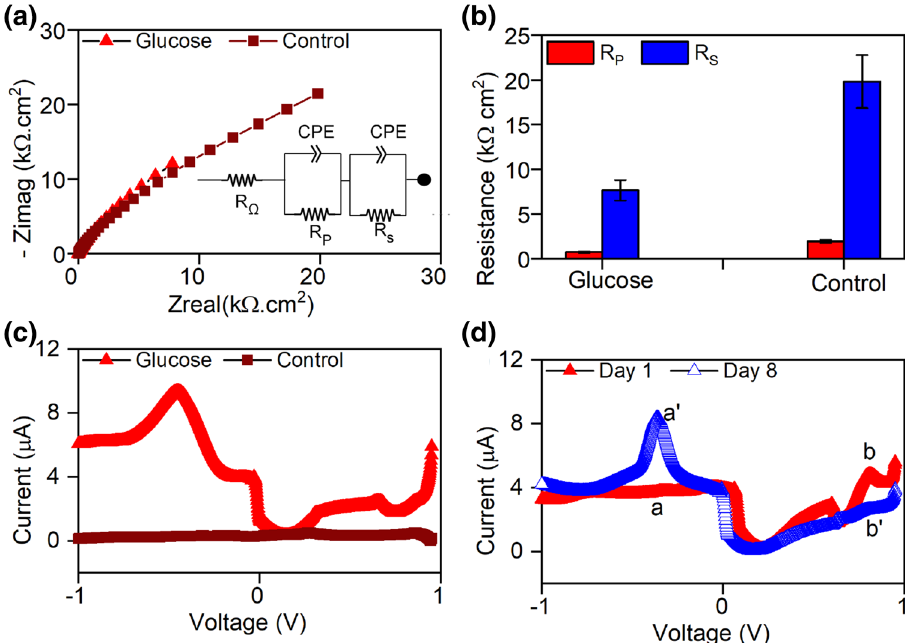
Figure 2. Electrochemical response of Geobacillus sp. strain WSUCF1 in glucose. ( a ) Nyquist plots for the entire frequency range (10 kHz to 10 MHz) (Inset shows electrical equivalent circuit used for fitting the EIS data); ( b ) Fitting results; ( c ) Representative differential pulse voltammetry scan; ( d ) DPV for glucose on temporal scale. Note All experiments were carried out in a 3-electrode electrochemical